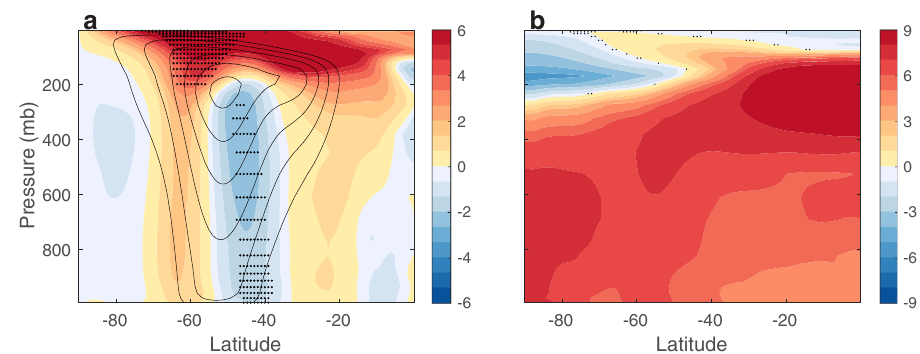
Fig. 3 The contribution of thermodynamic coupling to the response of the zonal mean fl ow. The effect of thermodynamic coupling on the response of the zonal mean a zonal wind (ms − 1 ) and b temperature (K) to anthropogenic emissions. Black contours show the mean zonal wind averaged over the 1980 – 1999 period from the FULL ensemble in intervals of 5 ms − 1 and maximum value of 30 ms − 1 . Small black dots in panel a show where the zonal wind changes are linked to the EKE shift (i.e., with R 2 ≥ 0.85). Black dots in panel b shows where the response is not statistically signi fi cant at the 5% level based on a Student ’ s t-test.